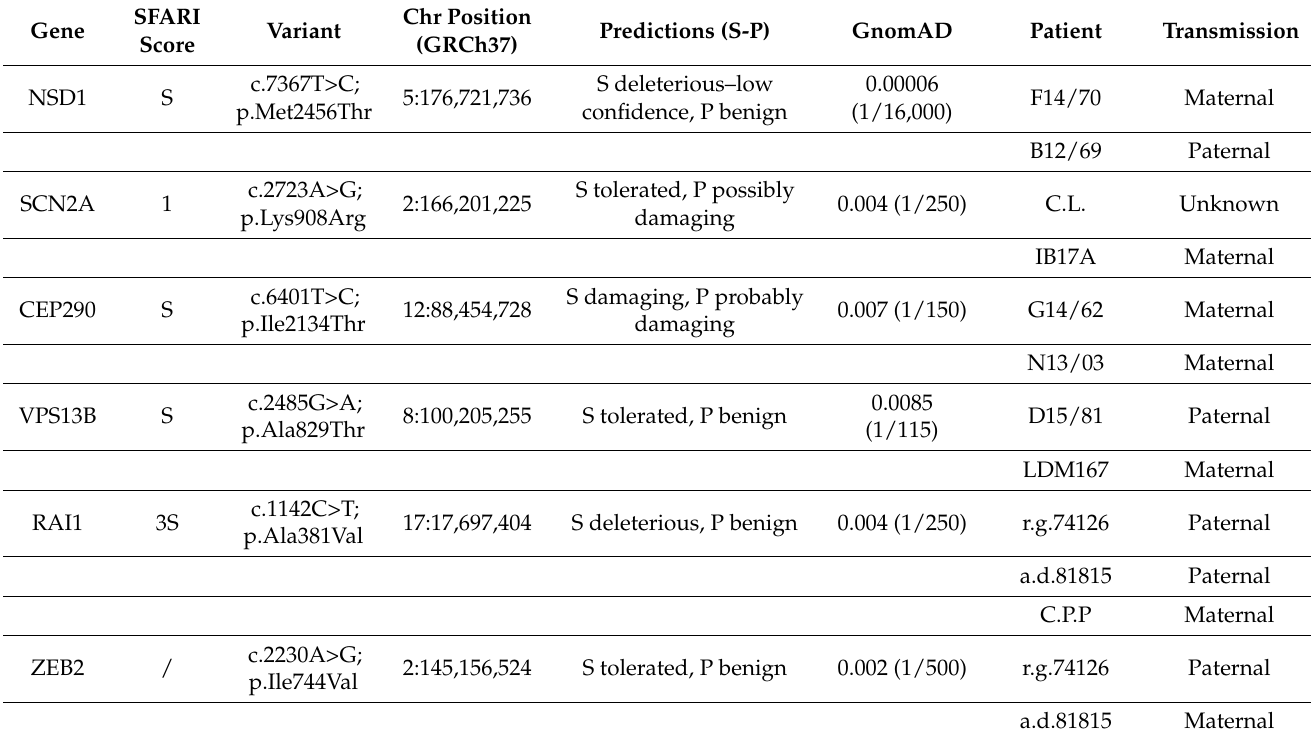
Table 7. Variants shared by two or three patients in our